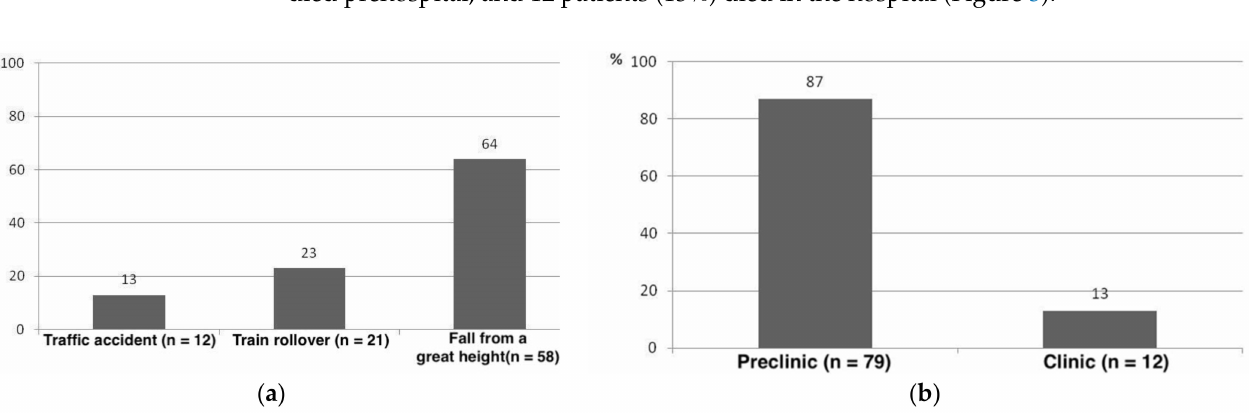
Figure 3. Distribution of accident mechanisms and localization of death (n = 91): ( a ) Most patients died as a result of a fall from a great height, followed by train rollovers and traffic accidents. ( b ) Majority of patients died in the prehospital setting (source: Haussmann [22],